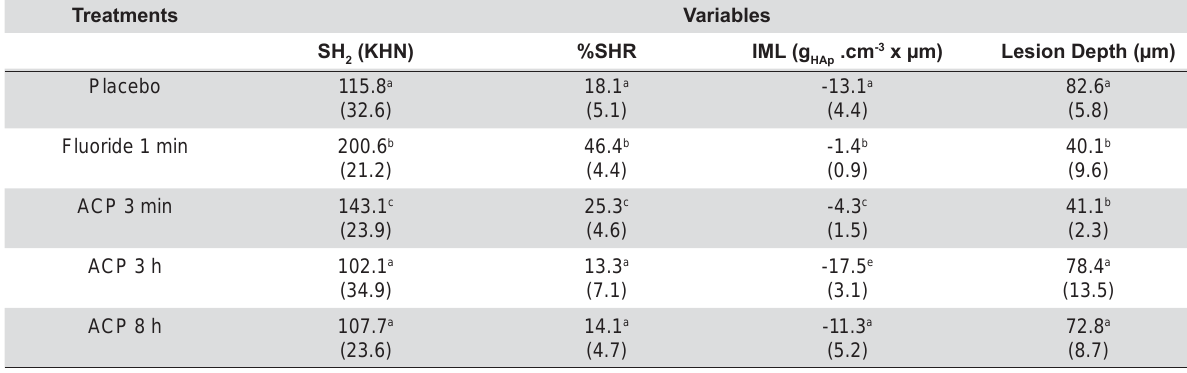
Table 1- Mean values (SD) of hardness (n=10) and synchrotron (n=6) enamel analysis according to the